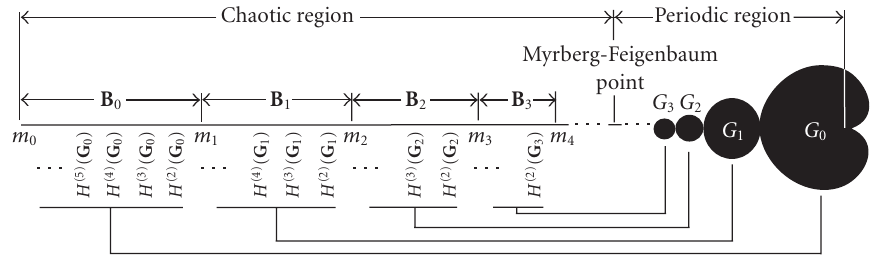
Figure 2.1. Sketch of the real Mandelbrot set, corresponding to the 1D quadratic map x n = x 2 by using the neighborhood of the real part of the Mandelbrot set. Both the separation of periodic and chaotic regions, and the correspondence between the gene G i and the chaotic band B i are